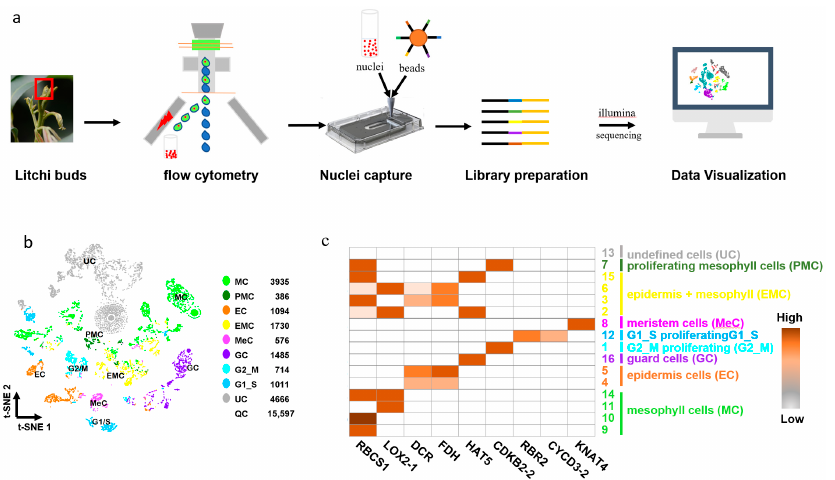
Figure 6. An example of snRNA sequencing using litchi bud nuclei. ( a ) Process of BD Rhapsody™ Single-Cell Analysis. ( b ) t-SNE plot showing 9 cell populations from the litchi bud. Each dot denotes a single cell. Colors denote corresponding cell clusters. ( c ) Expression patterns of representative cluster-specific marker genes. KNAT4: Homebox protein knotted-1-like 4; CYCD1-4: Cyclind3-2; CDKB2-2: Cyclin-dependent kinase B2-2; RBR2: Retinoblastoma-related protein2; LOX2.1: Lipoxygenase 2.1; RBCS1: Rubisco bisposphate carboxylase small subunit 1; HAT5: homeobox-leucine zipper protein HAT5; FDH: Fiddlehead; DCR: Defective in cuticular ridges.